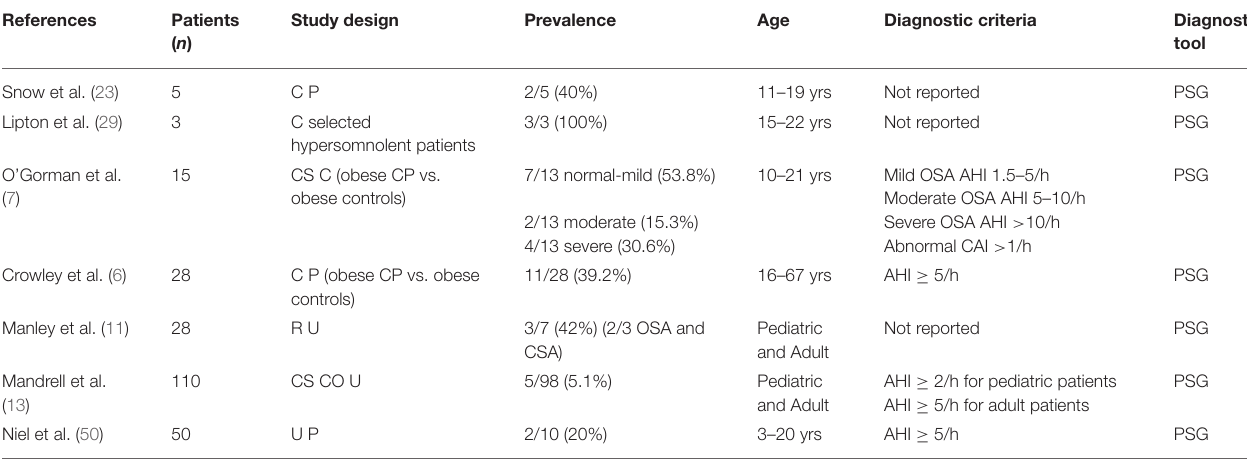
TABLE 1 | Sleep-related breathing disorders in patients with